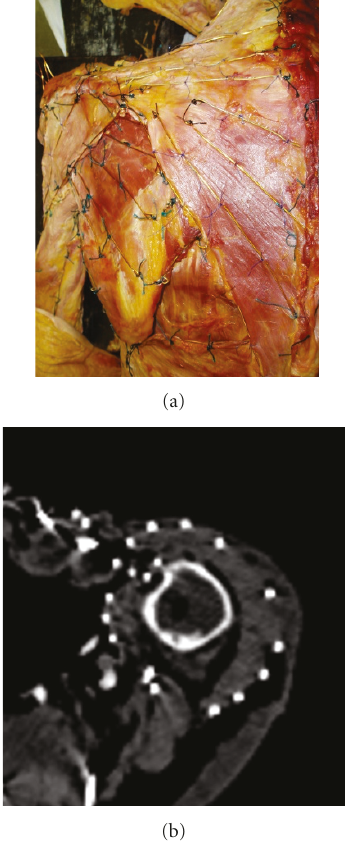
Figure 1: (a) Metallic markers were attached to the outer surface of each muscle following the muscle fibre paths. (b) Axial CT image following model